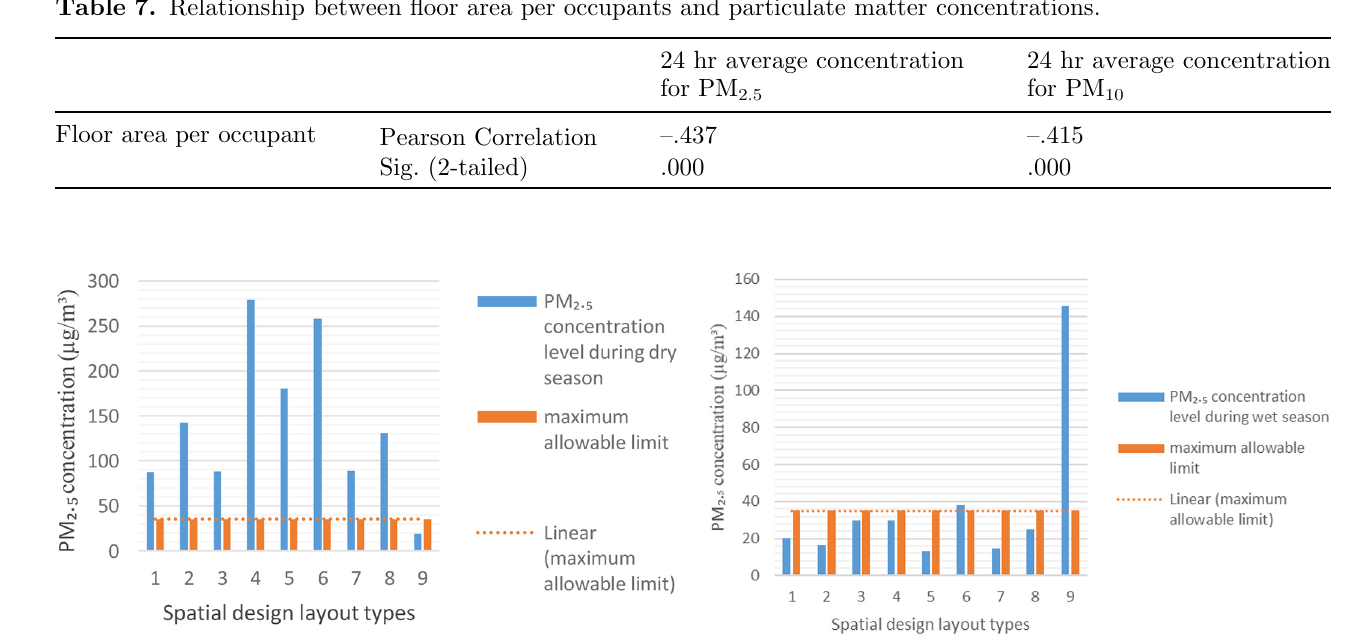
Fig. 4. PM 2.5 concentration levels in the different spatial design layouts during dry season.